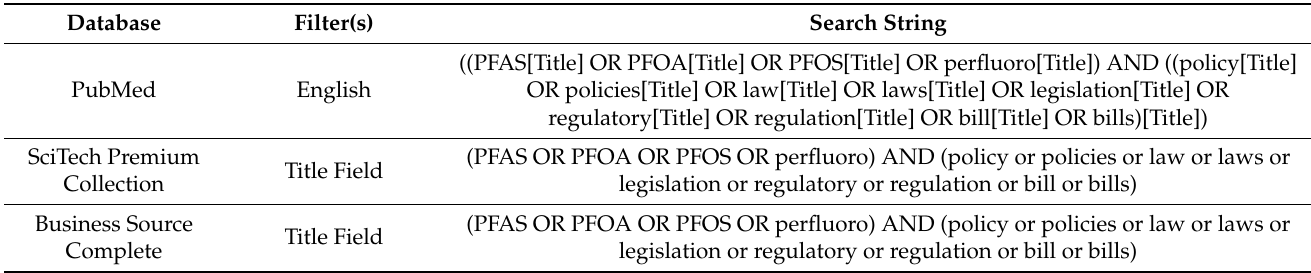
Table 2. Databases searched and search parameters used to identify relevant